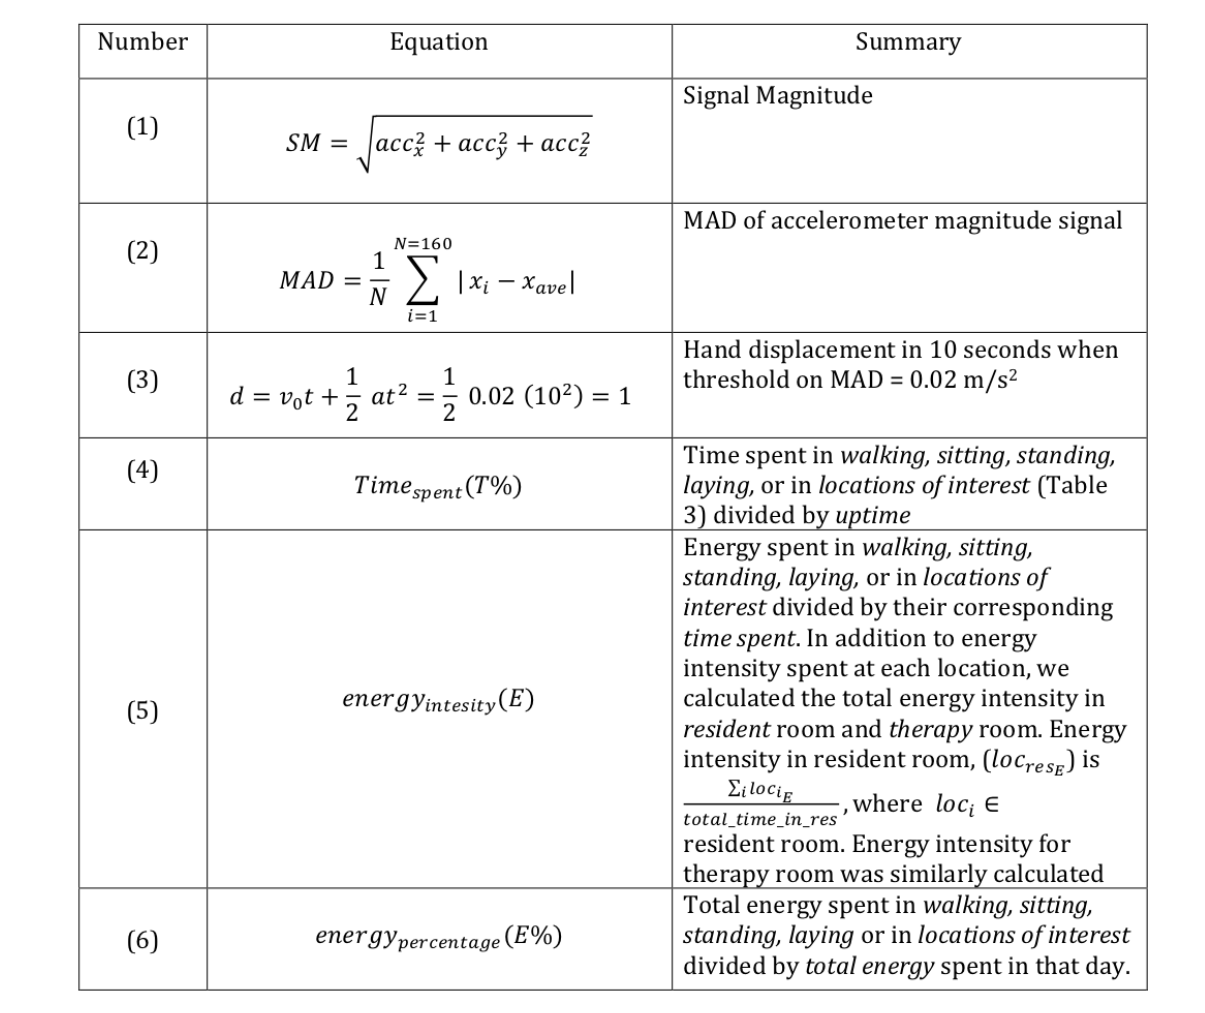
Figure 2. Equations. MAD: mean absolute deviation.